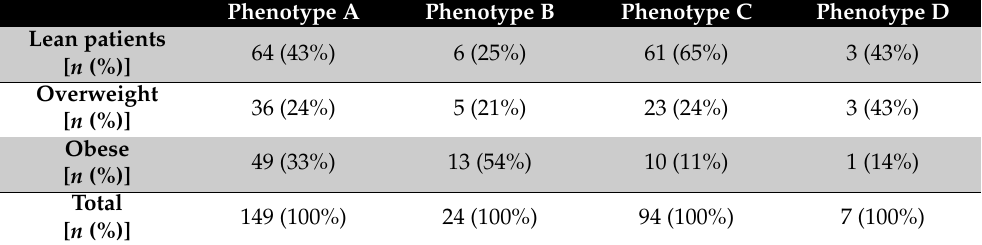
Table 2. Prevalence of different body weights for patients in different PCOS phenotype groups.